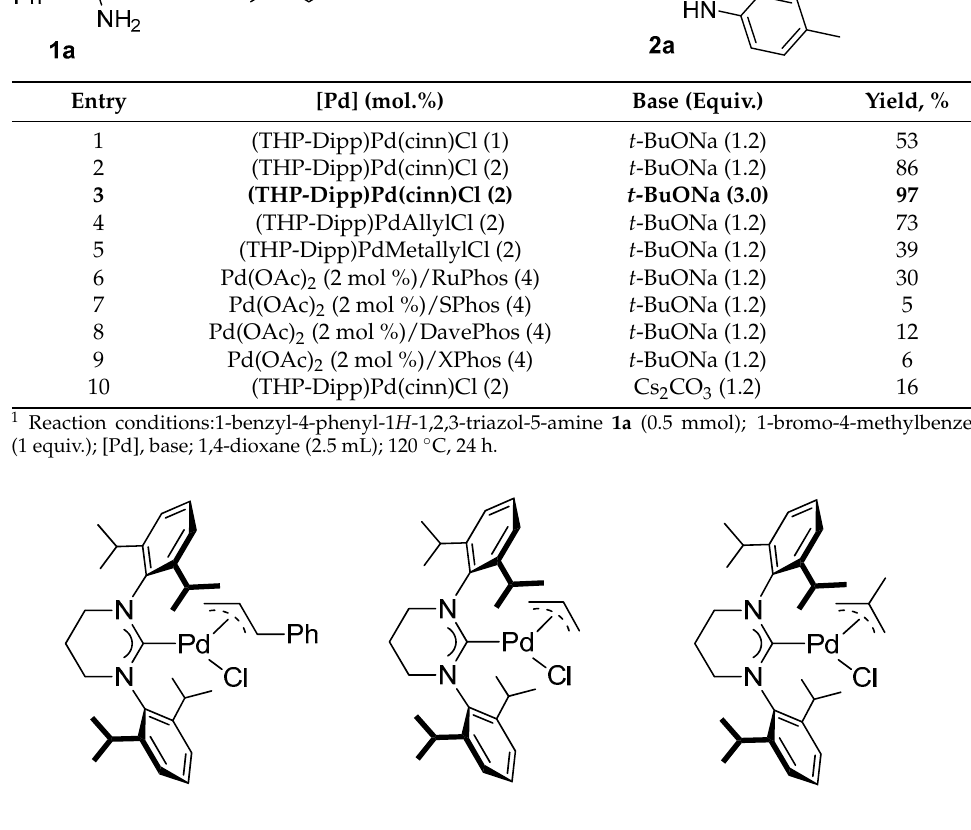
Figure 3. Structures of (THP-Dipp) Pd complexes.